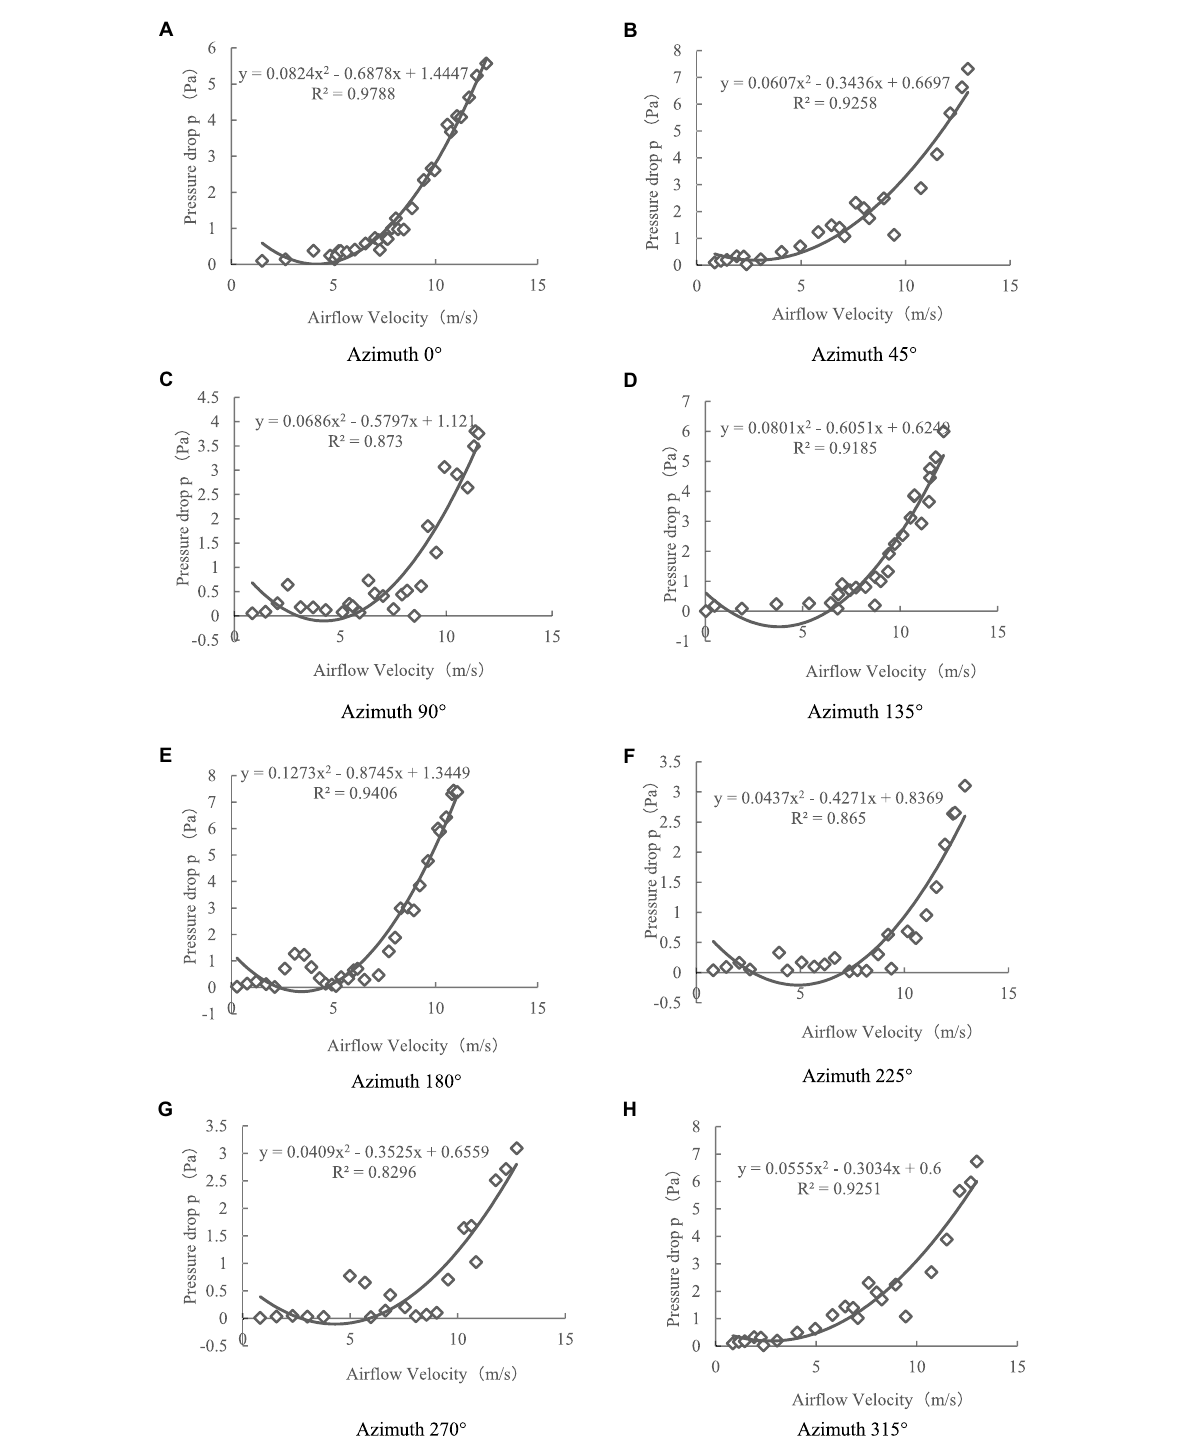
FIGURE 9 Variation of canopy pressure drop with airflow velocity under different azimuth conditions. (A) Azimuth 0 ° . (B) Azimuth 45 ° . (C) Azimuth 90 ° . (D) Azimuth 135 ° . (E) Azimuth 180 ° . (F) Azimuth 225 ° . (G) Azimuth 270 ° . (H) Azimuth 315 °